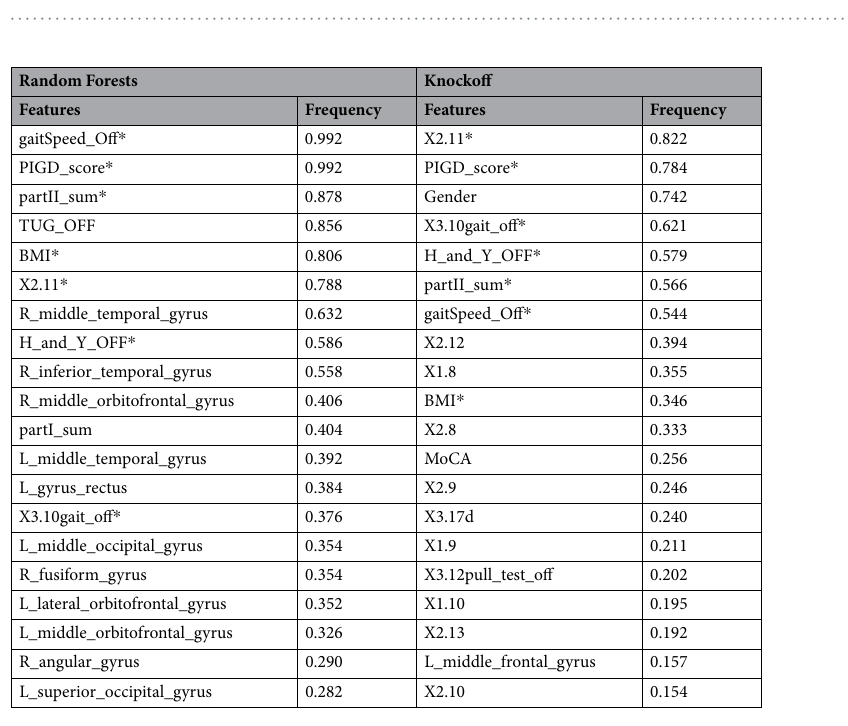
Table 8. Top seven features ( * ) are selected by both methods (RF and KO): gaitSpeed_Off, PIGD_score, partII_ sum, BMI, X2.11, H_and_Y_OFF,